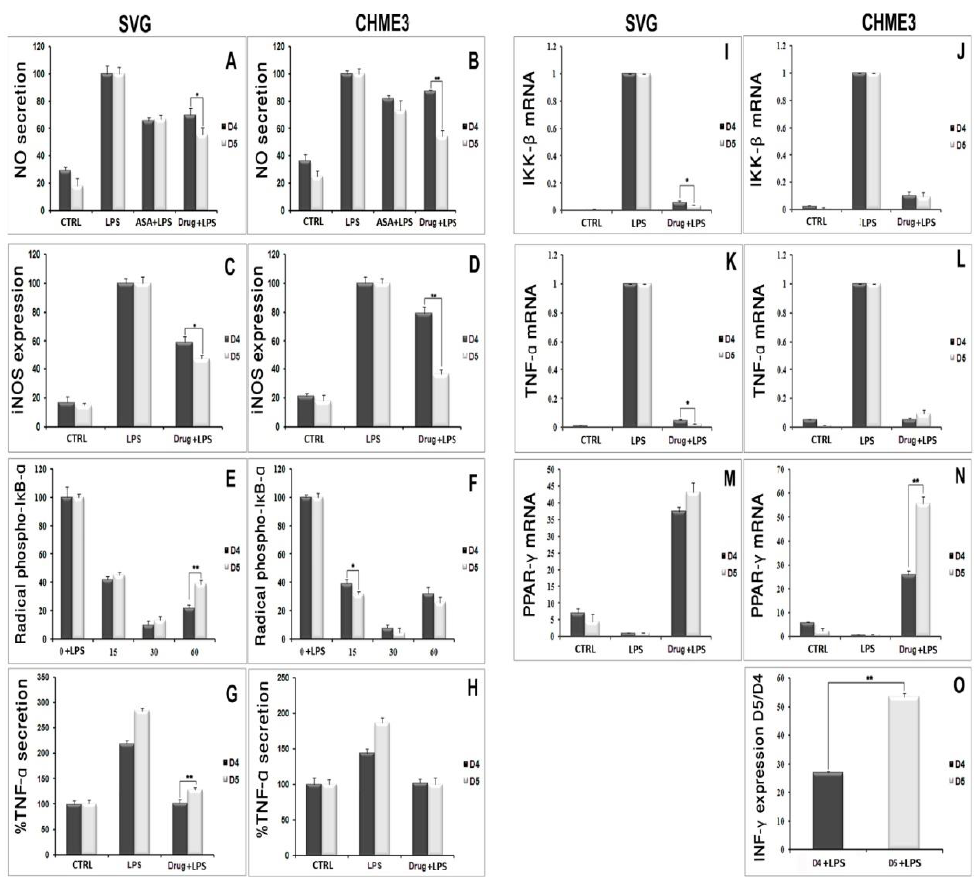
Figure 11. In vitro comparison of the druggability potential of methylenedioxy and hydroxymethyl piperamide derivatives on the LPS-inducing inflammation in the astrocytic glial ( SVG ) and microglial ( CHME3 ) cells: Astrocytic glial (SVG) and microglial (CHME3) cells were treated with D4, D5, and ASA in their respective EC50 values (0.86 µM, 0.71 µM, and 52.73 µM, respectively) for 2 h, and then incubated with LPS (100ng/mL) for 24h. the efficacies of all com- pounds were compared using the pairwise Student’s t -test, with p ≤ 0 .05. The in vitro tests con- sisted of assessing the level of NO quantification using Griess reagent (( A , B ) in SVG and CHME3, respectively); protein secretion of iNOS (( C , D ) in SVG and CHME3) and phospho- IκB - α (( E , F ) in SVG and CHME3) using Western blot analysis;cytokine protein secretion (TNF- α (( G , H ) in SVG and CHME3) and INF- γ (( O ) in CHME3)) using Enzyme-Linked Immunosorbent Assay (ELISA); and cytokine and enzyme genes expression (IKK- β (( I , J ) in SVG and CHME3), TNF- α (( K , L ) in SVG and CHME3), and PPAR- γ (( M , N ) in SVG and CHME3)) using quantitative real-time PCR.The Western blot and RT-PCR data were normalized by their respective level of GAPDH protein and gene expressions. The level of INF- γ in section ”O” ispresented as the ratio of INF- γ secreted in drug-treated LPS-stimulated cells and their respective drug-untreated LPS-stimulated CHME3 cells. * p < 0.05; ** p < 0.01 probability. 5. Discussion The current study focused on the evaluation of the pharmacological properties of piperine-derived D5 and D4 to repress glial cells' over-activation and the neural cyto- toxicity caused by neuroinflammation. Neuroinflammation is the activation of an im- mune response in the CNS (brain and spinal cord) by microglia and astrocytes. Typically, neuroinflammation occurs in response to CNS injury, infection or toxins, or as a conse- quence of autoimmunity [55 – 57]. While transient neuroinflammatory signaling plays a